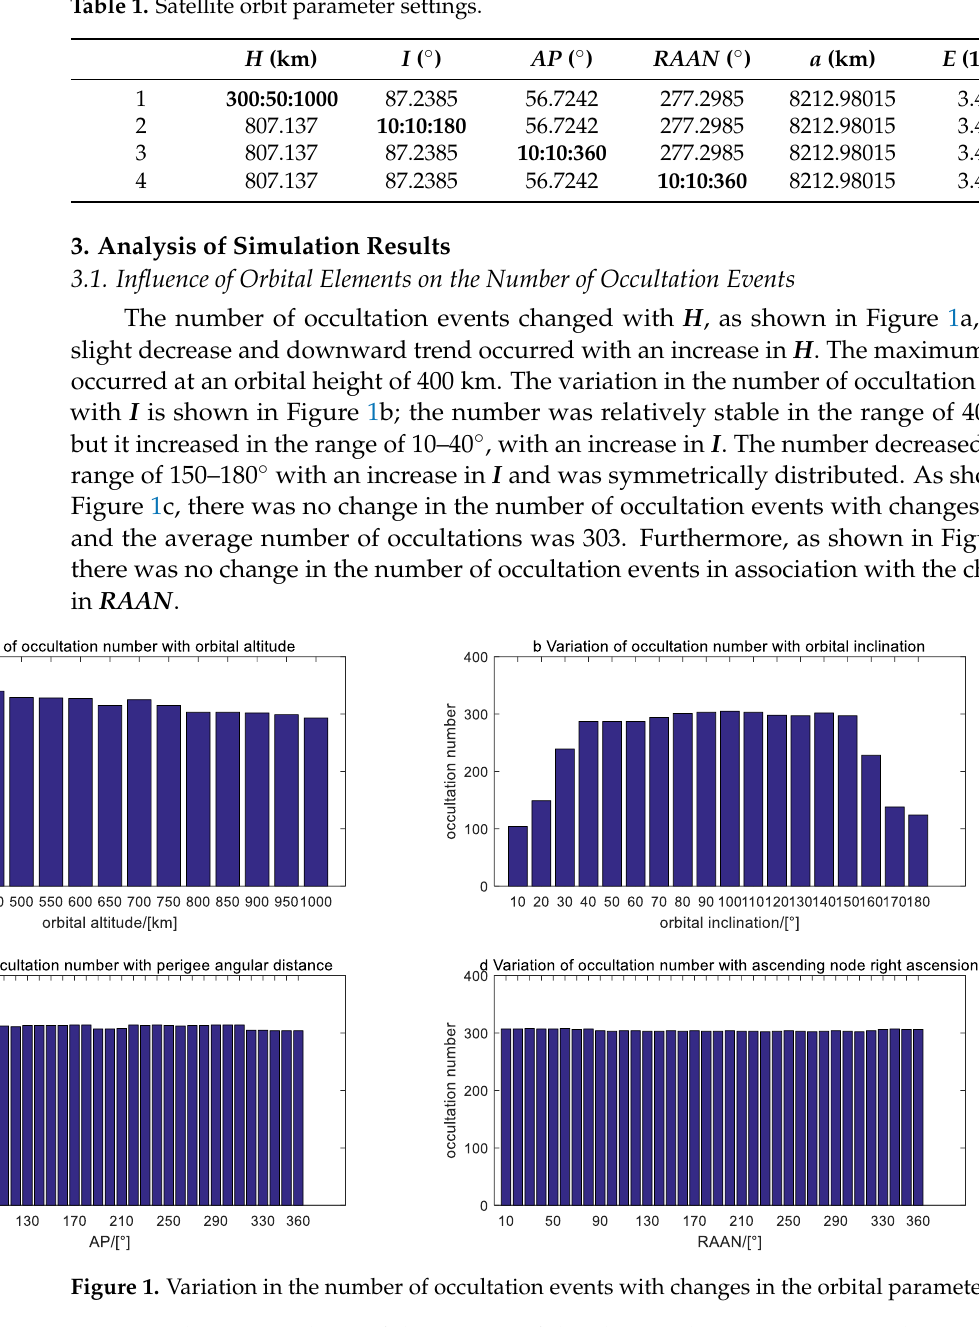
Table 1. Satellite orbit parameter settings.